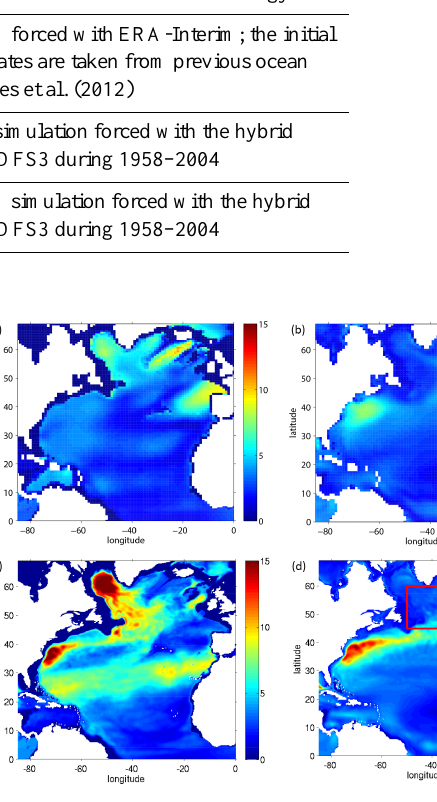
Figure 3. The standard deviations of the monthly density (in gm − 3 ) averaged on the 1000–3000m (a, c) and the top 1000m (b, d) layers in ORCA1-R07 (a, b) and ORCA025-G70 (c, d) runs (for the 45- year period 1960–2004 inclusive). Also shown in the right bottom panel by red rectangle is the region that is used to calculate density anomaly (area between 50–35 ◦ W and 45–60 ◦